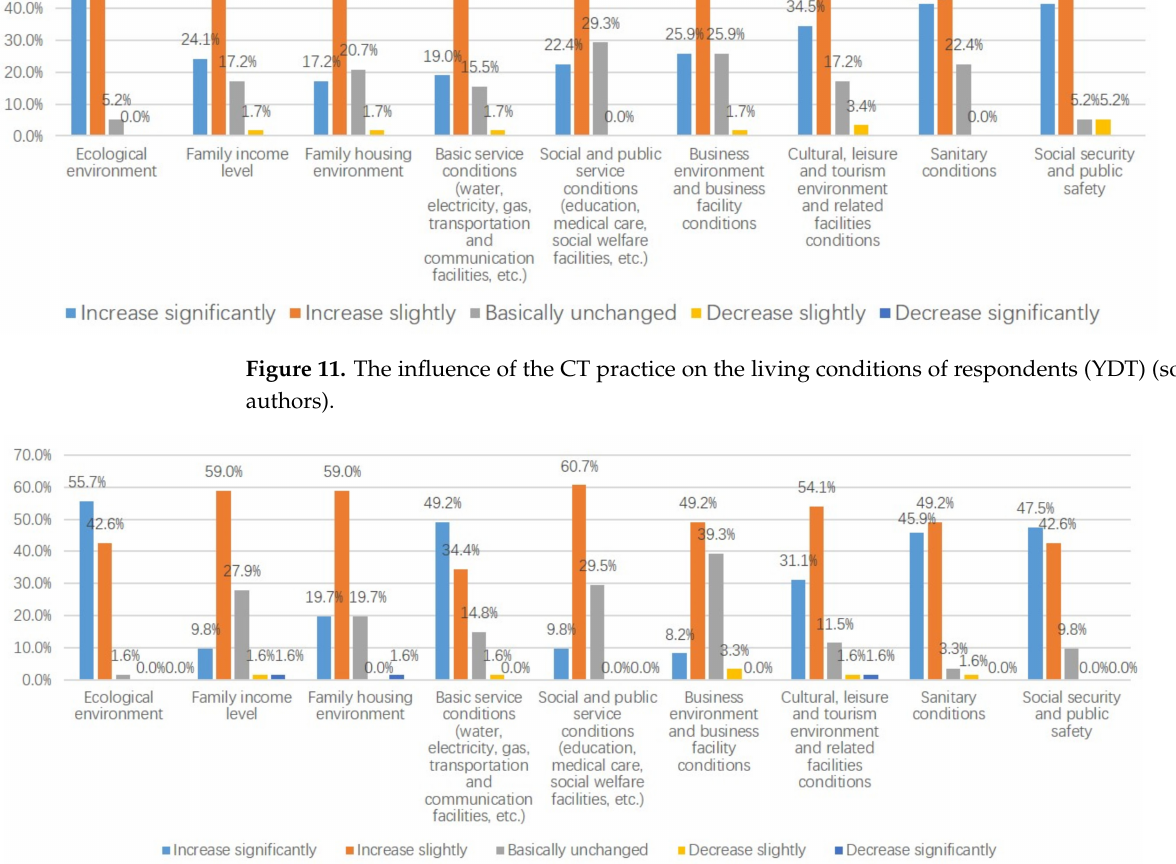
Figure 12. The influence of the CT practice on the living conditions of respondents (WLLTT) (source: